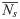
Variation in average N
s and its statistical significance.Change in Ns¯ with varying recipe size cut-offs reveals the nature of food pairing across the spectrum of recipe sizes. The Ns¯ values for regional cuisines were consistently on the lower side compared to their random counterparts. Category controlled random cuisine displayed average N
s variation close to that of the ‘Random control’. Frequency controlled as well as ‘Category + Frequency’ controlled random cuisines, on the other hand, displayed average N
s variations close to that of the real-world cuisine.